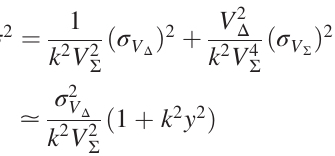
FIG. 21. Top row: distribution of the beam position measured in BPM (a) P1, (b) P2 and (c) P3 for a set of 500 consecutive beam pulses. Bottom row: distributions of the corresponding position residuals for BPMs (d) P1, (e) P2 and (f) P3; the red lines show Gaussian fits to the respective data.